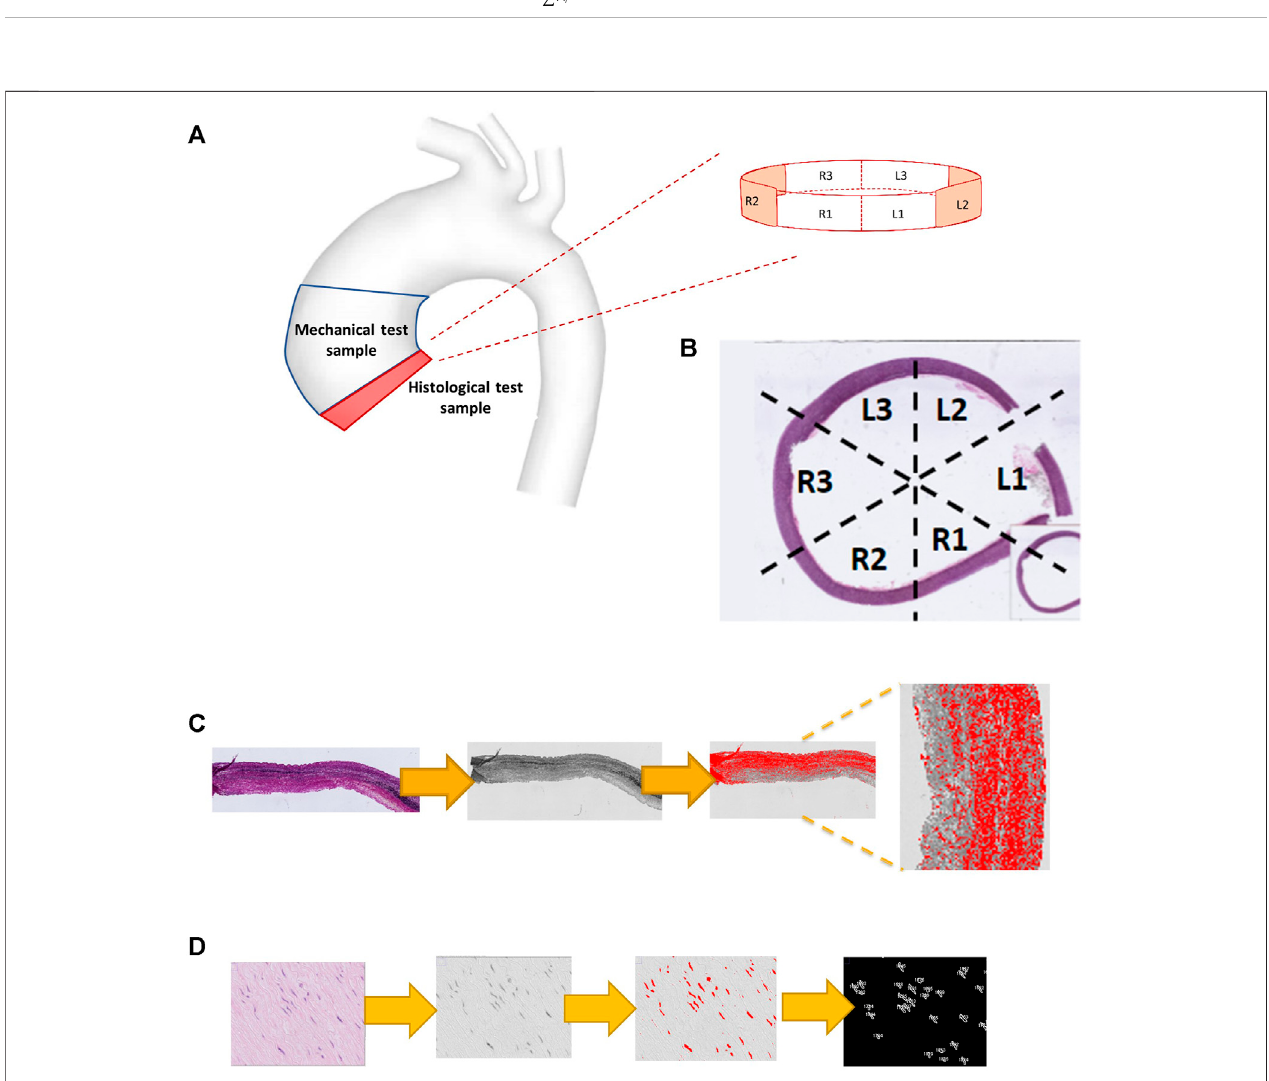
FIGURE 2 | Computational pathology: regional histological analysis. (A) the origin of the histological specimen from the ATAA region. (B) Whole slide imaging demonstrating the division into six segmental regions. (C) Computational steps used to quantify elastin density (using EVG stained slide image), including RGB-stack imageconversion,thresholdingandmeasurement.Collagenquanti fi cation usesthesamestepsbut foraPSRstainedimage. (D) displays thecomputationalstepsused to measure smooth muscle cell count (from an H&E-stained slide image) including particle analysis, using a size window of 20 – 100 μ m.